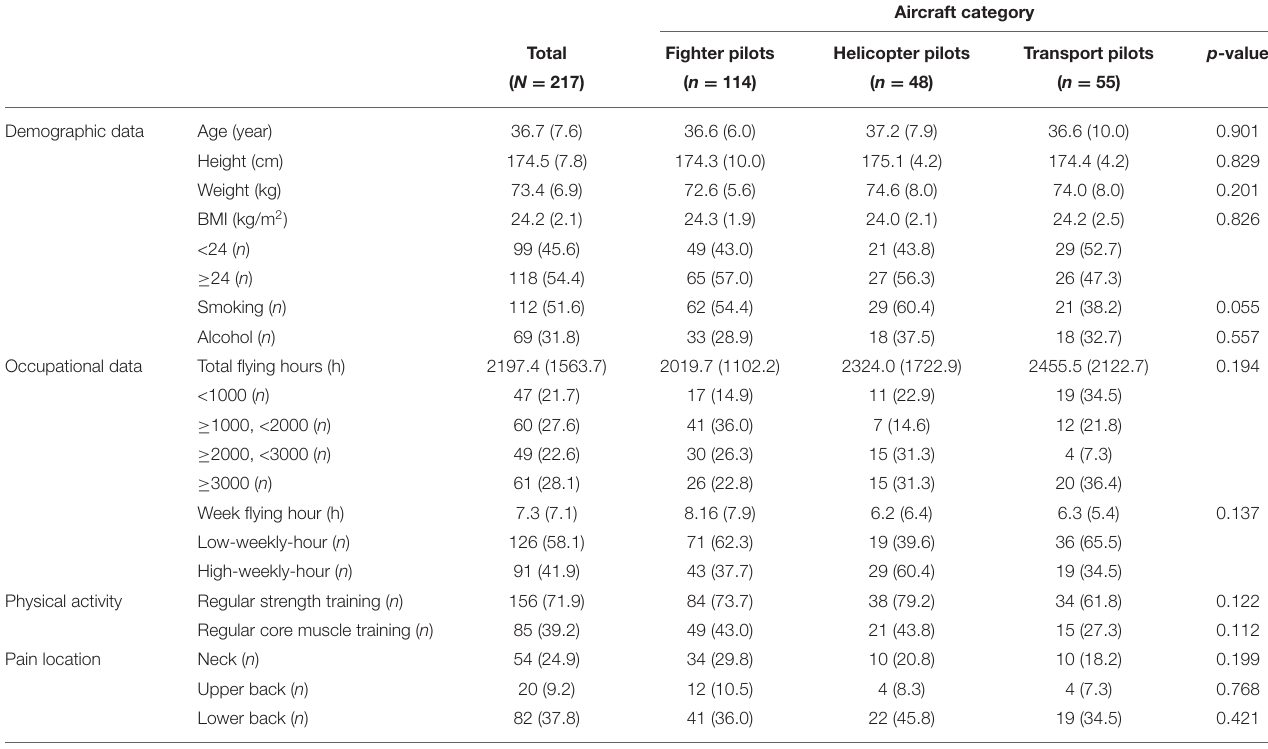
TABLE 1 | Demographic and other characteristics of the study